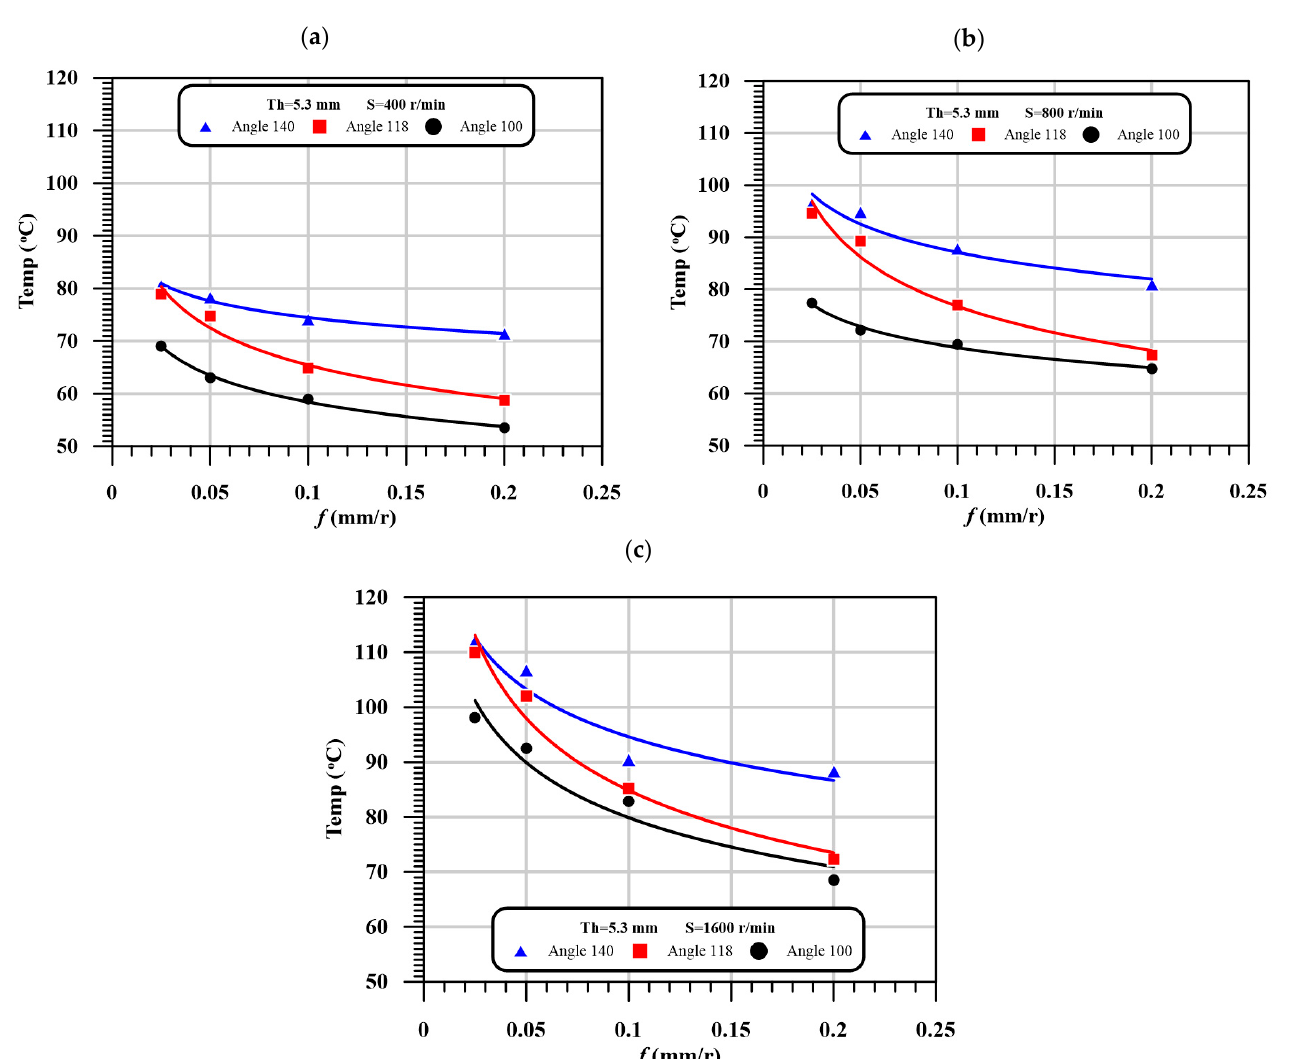
Figure 7. The effect of feed on the heat affected zone with different point angles at different speeds, ( a ) At thickness of 5.3 mm and speed = 400 r/min; ( b ) At thickness of 5.3 mm and speed = 800 r/min; ( c ) At thickness of 5.3 mm and speed = 1600 r/min.